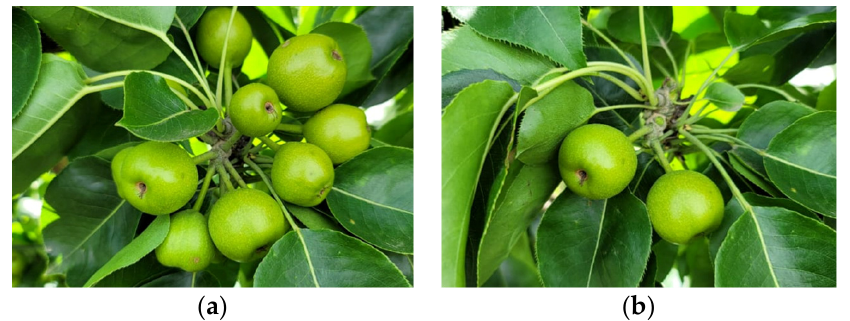
Figure 5. ‘Nijisseiki’ cluster before ( a ) and after ( b ) thinning. Photo credit: Steven Singh, Seeka Australia Pty Ltd.